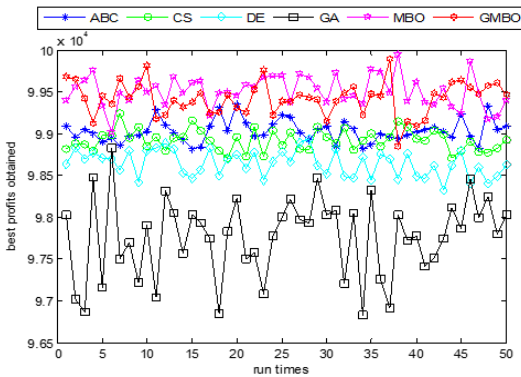
Figure 8. Comparison of the best values on KP5 in 50 runs.